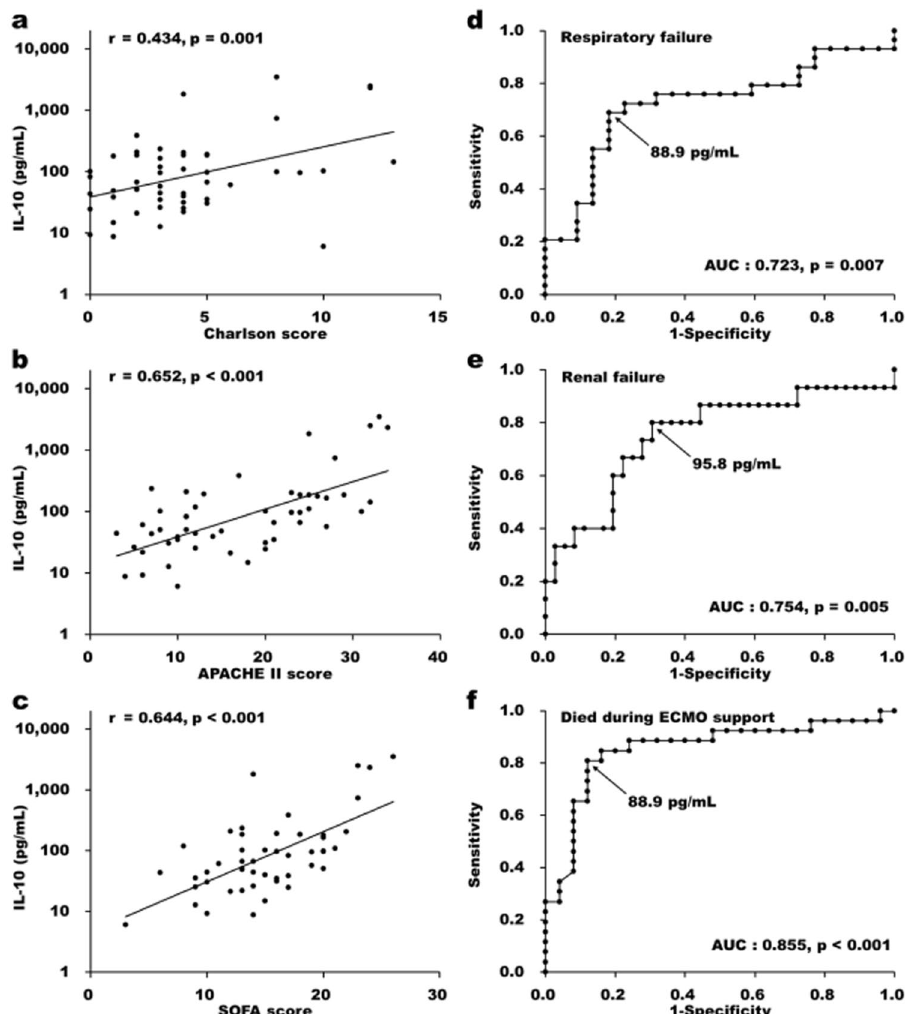
Figure 2. Initial plasma interleukin-10 levels were associated with higher chances of organ failures and mortality in ARDS patients during ECMO support. Plasma interleukin-10 level at day 0 was associated with the severity of illness as evaluated one day after receiving ECMO by comorbidity index Charlson ( a ), acute physiology and chronic health evaluation (APACHE) II ( b ), and combining sequential organ failure assessment (SOFA) score ( c ). Furthermore, Interleukin-10 level at day 0 predicted respiratory ( d ) and renal ( e ) failures in the death group, and served as an excellent predictive value for mortality during ECMO support ( f ), with an area under the receiver operating characteristic curve equaled